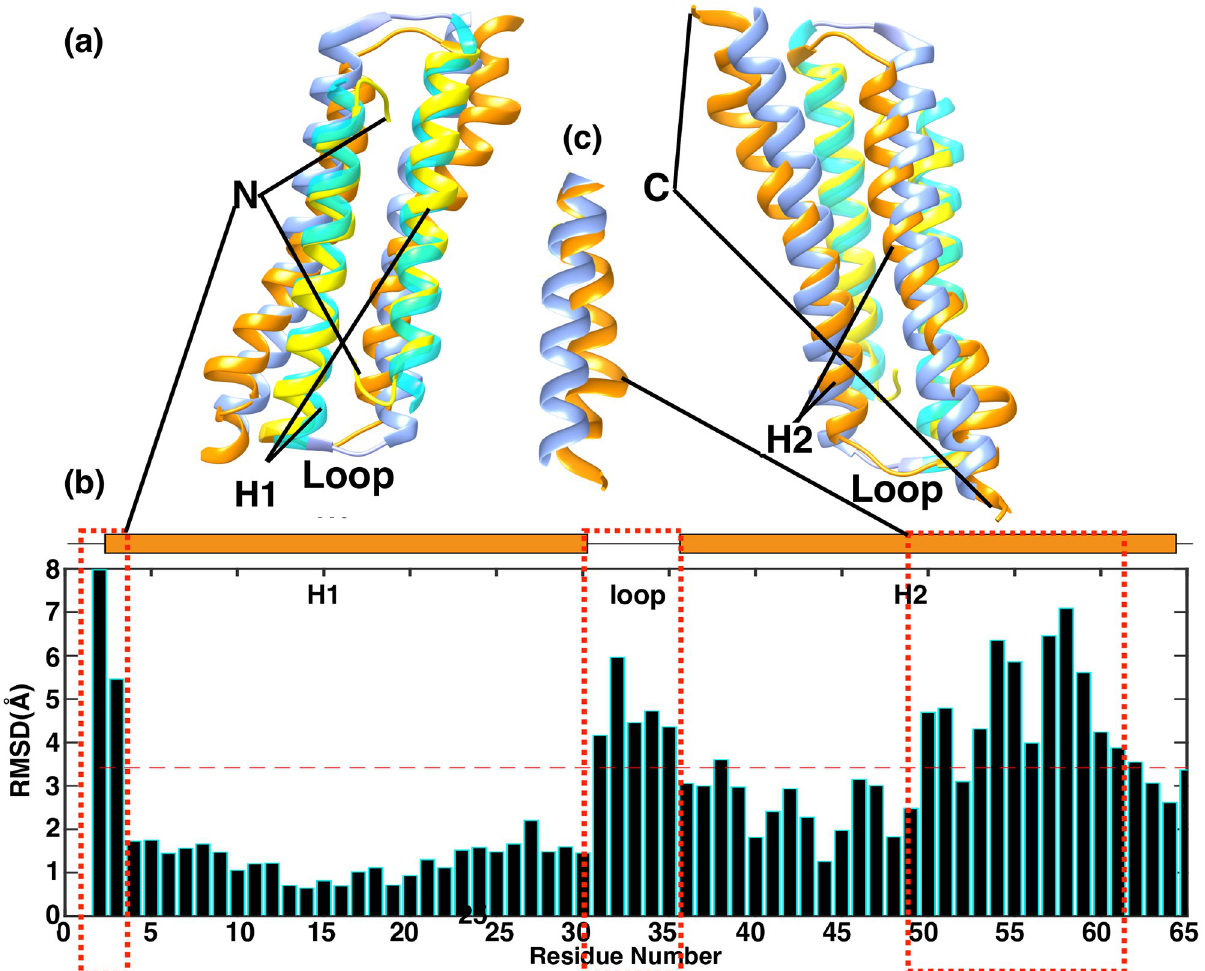
Fig 3. Comparison of the solution structure of PRC1-DD and the corresponding segments in crystal structure. (a) Superimposition of ribbon representation of the PRC1-DD lowest-energy solution structure and crystal structure; H1 and H2 of the solution structure are colored yellow and orange, respectively, while H1 and H2 of the crystal structure are colored in cyan and blue, respectively; C and N tags signify C- and N-terminal ends, respectively. (c) Enlargement of the dotted box in (a) . Figures were plotted using MATLAB, while the alignment was performed using CHIMERA.